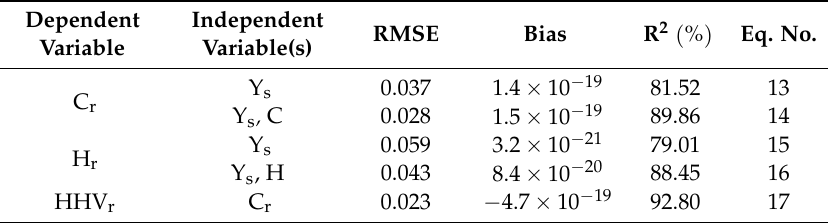
Table 3. Regression models for predicting the C and H contents and HHV of torrefied